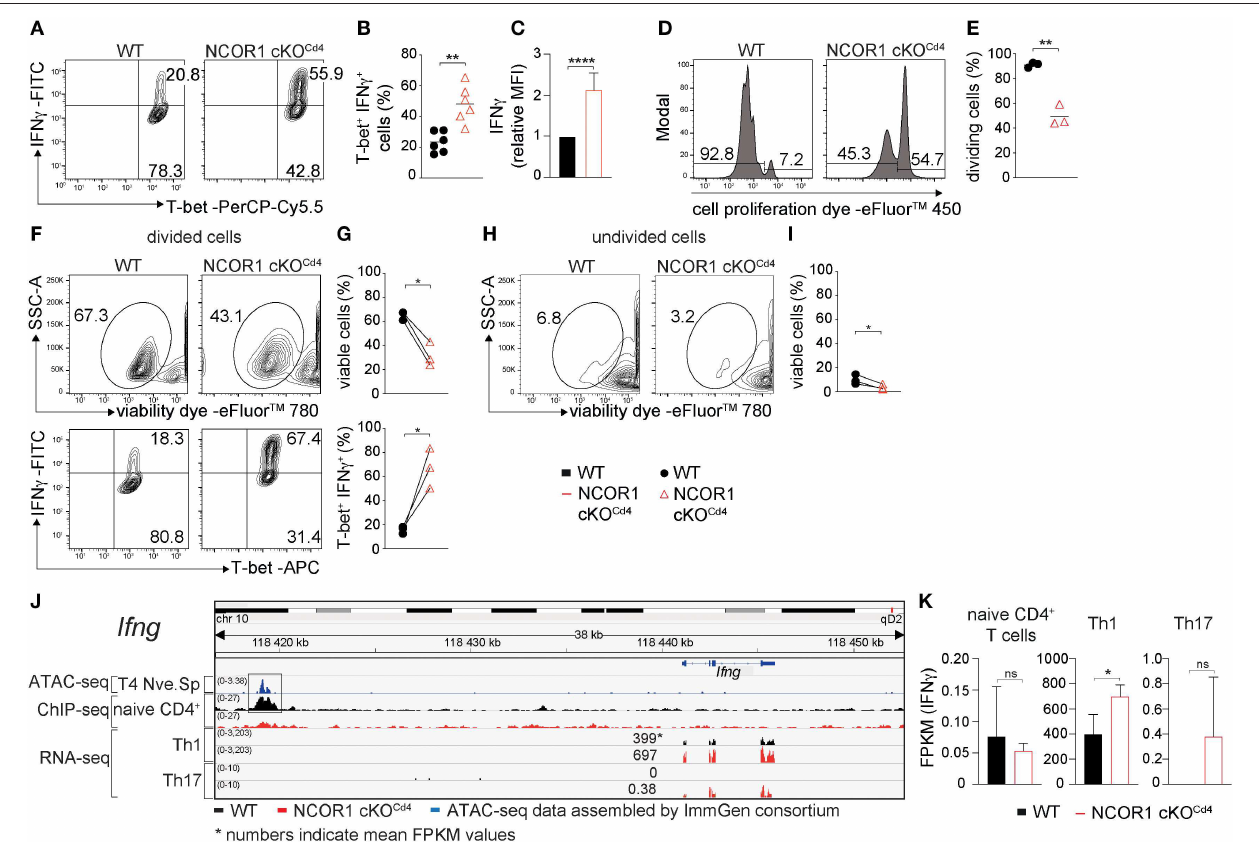
FIGURE 3 | Enhanced IFN γ expression in NCOR1-deficient Th1 cells. (A) Naïve WT and NCOR1 cKO Cd4 CD4 + T cells were activated with anti-CD3 ε /anti-CD28 for 3 days in the presence of Th1-inducing cytokines. Contour plots depict T-bet and IFN γ expression. (B) Summary of all experiments performed as described in (A) . (C) Summary graph of mean fluorescence intensity of IFN γ expression levels. For each experiment, WT levels were set as 1 and relative IFN γ levels were calculated. (D) Representative histograms depict proliferation. Regions mark divided (left) and undivided cells (right). (E) Diagram showing the percentages of cells that underwent at least one cell division. (F) Contour plots in the upper panel show viability dye vs. side scatter (SSC-A) for WT and NCOR1 cKO Cd4 Th1 cells with at least one cell division (left region in D ). The lower contour plot panel depicts T-bet and IFN γ expression within proliferated WT and NCOR1 cKO Cd4 Th1 cells. (G) Summary shows percentages of viable cells (upper graph) and percentages of T-bet + IFN γ + cells (lower graph). (H) Contour plots show viability dye vs. side scatter (SSC-A) for WT and NCOR1 cKO Cd4 Th1 cells of undivided cells (right region in D ). (I) Summary shows percentages of viable undivided cells. (J) Integrative Genomics Viewer (IGV) ( 34, 35) screen shot displaying the Ifng gene locus. ImmGen consortium ATAC-seq peaks (GSE 100738) of splenic naïve CD4 + T cells are shown in the 1st row. The 2nd and 3 rd rows display ChIP-seq tracks from WT and NCOR1 cKO Cd4 naïve CD4 + T cells, respectively. Rows 4–7 display RNA-seq tracks from in vitro -generated WT and NCOR1 cKO Cd4 Th1 and Th17 cells. (K) Diagrams show the summary of Ifng FPKM values obtained by RNA sequencing of naïve CD4 + T cells, and of in vitro -generated Th1 and Th17 cells. (B,E) The horizontal bars indicate the mean. * P < 0.05, ** P < 0.01, **** P < 0.0001, ns, not significant (unpaired two-tailed t -test or paired t -test for G,I ). (G,I) Lines indicate paired experiments. (A,D,F,H) Numbers indicate the percentage of cells in the respective quadrants or regions. Data are representative (A,D,F,H) or show summary of 6 (B,C) and 3 (E,G,I,K) samples that were analyzed in 6 (B,C) and 3 (E,G,I,K) independent